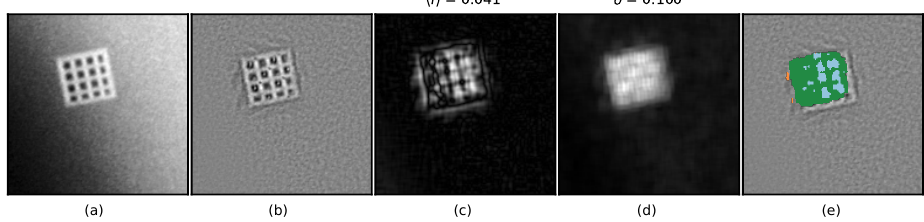
Figure 13. Results for the AE model trained on both accepted welds and those with defects, a synthetic raster anomaly test sample. ( a ) is input, ( b ) is the residual image, the residual analysis kernel results are for average kernel in ( c ) and standard deviation in ( d ). Above the patch is the maximum value indicated. Kernels above thresholds are indicated in ( e ) with blue ( (cid:104) I (cid:105) and σ ), green ( σ ), and orange ( (cid:104) I (cid:105)